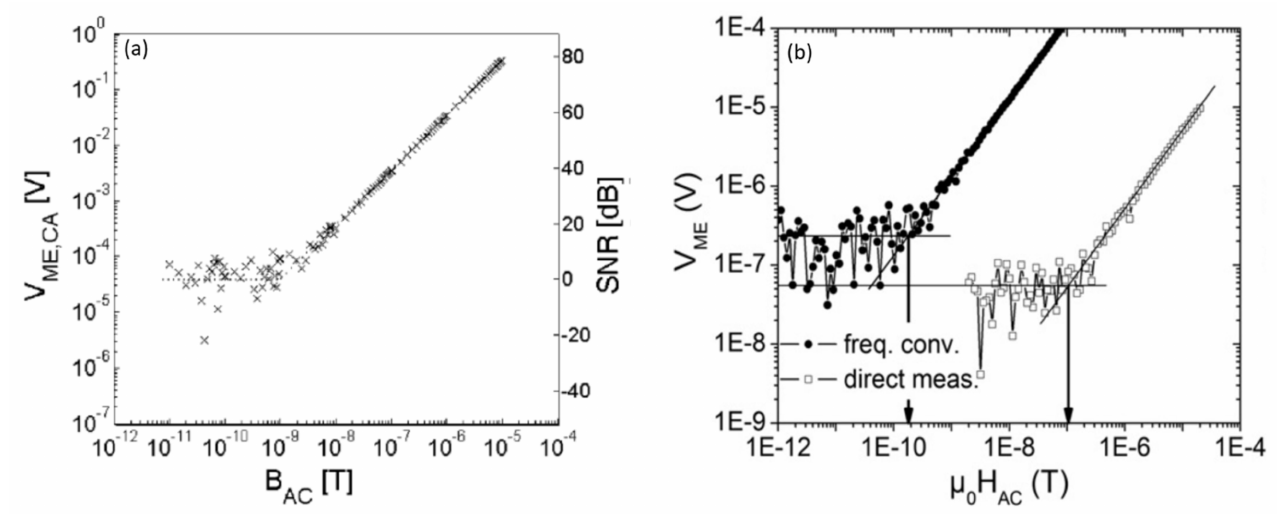
Figure 5. ( a ) Sensitivity of the modulated AlN/FeCoBSi sensor at 1 Hz. ( b ) The direct LOD measurement of AlN/FeCoBSi sensor at f AC = 10 Hz and H Bias = − 5 Oe and by frequency conversion with an RMS amplitude of H mod = 3.96 Oe and f mod = 1001 Hz. Adapted with permission from ref. [33]. Copyright 2021 Elsevier